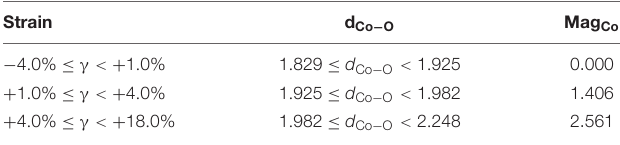
TABLE 1 | Bond length, d Co − O in Å and magnetic moment localized at Co atom, Mag Co in µ B of LaCoO 3